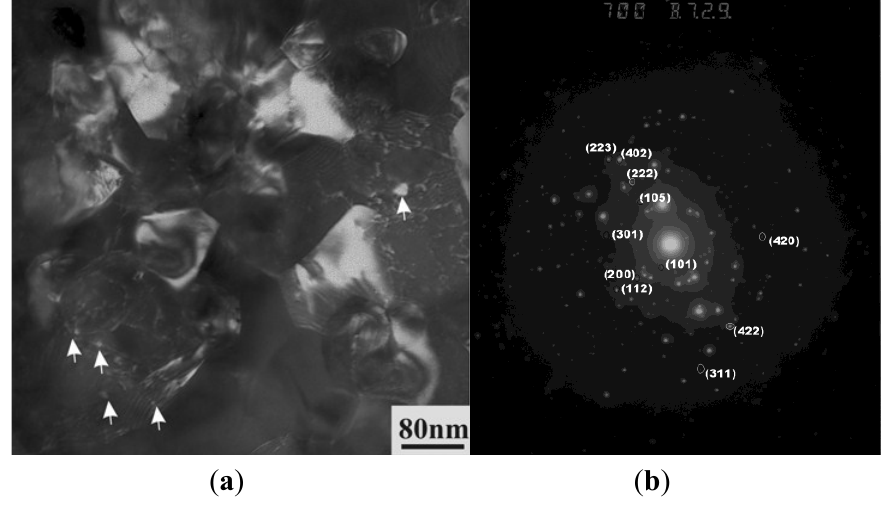
Figure 4. ( a ) TEM dark-field images and ( b ) diffraction pattern showing